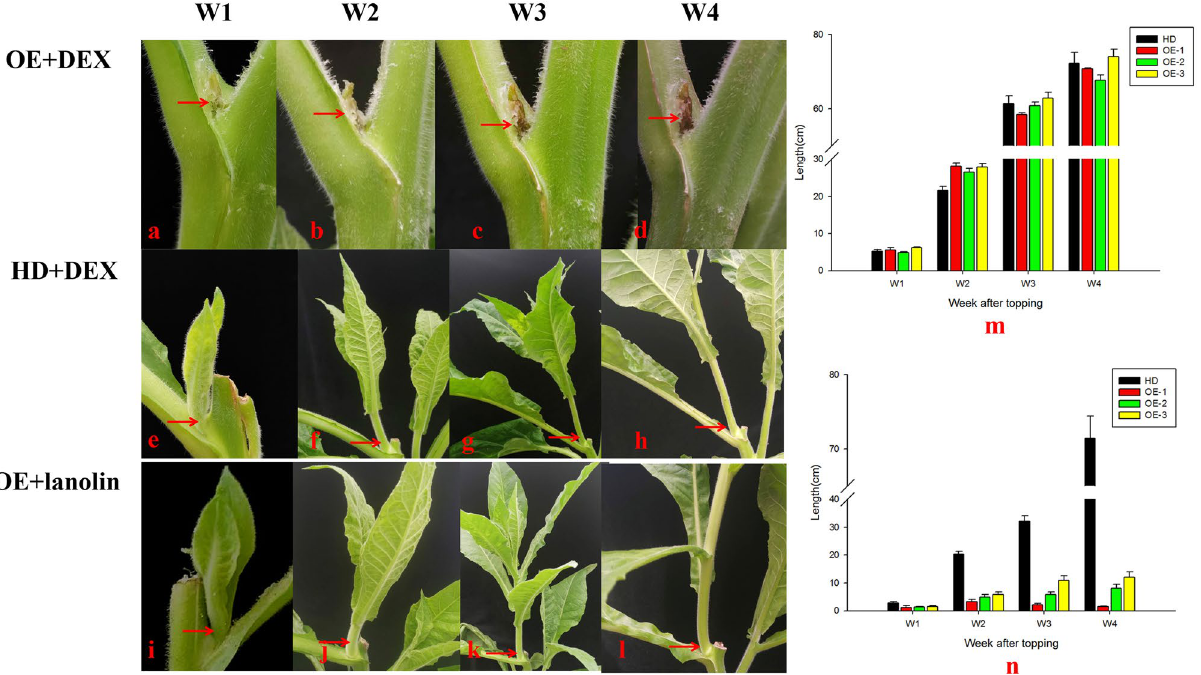
Figure 4. Growth of the axillary buds of the first leaf after topping in positive transgenic and control plants. ( a – d ): growth of the axillary buds at the application site treated with both lanolin and 50 µM dexamethasone in positive transgenic plants (from left to right: 1, 2, 3 and 4 weeks after topping); ( e – h ): growth of the axillary buds at the application site treated with both lanolin and 50 µM dexamethasone in control plants (from left to right: 1, 2, 3 and 4 weeks after topping); ( i – l ) growth of the axillary buds at the application site treated with lanolin in positive transgenic plants (from left to right: 1, 2, 3 and 4 weeks after topping); ( m ) length of the axillary buds at the application site treated with lanolin after topping in control plants and 3 positive transgenic lines; ( n ) length of the axillary buds at the application site treated with both lanolin and 50 µM dexamethasone after topping in control plants and 3 positive transgenic lines.